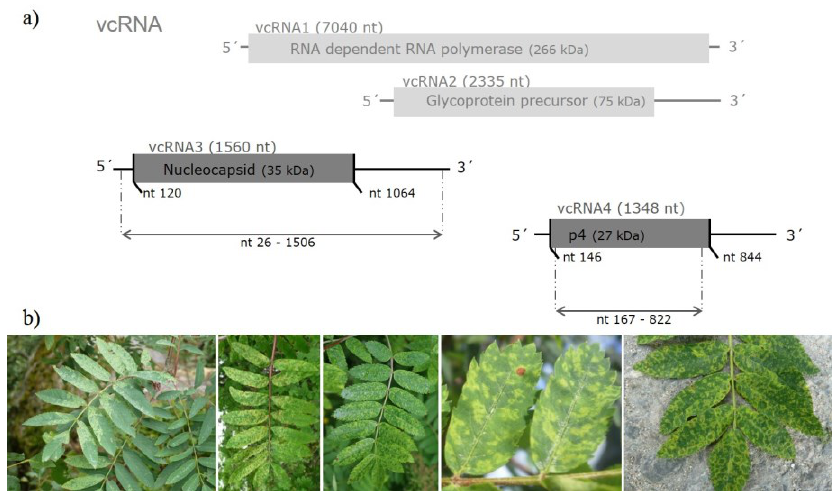
Figure 1. ( a ) Schematic representation of viral copy RNAs (vcRNA) of the EMARaV genome and nucleotide (nt) position of analyzed genome regions (grey arrows); ( b ) Leaves of European mountain ash with typical symptoms of EMARaV infection such as chlorotic ringspots and mottling found in different locations at Germany, Scotland, Norway, Sweden and